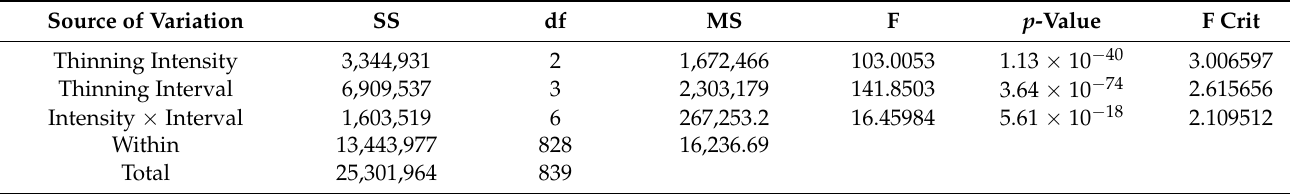
Table A6. Two-way ANOVA test for evapotranspiration.